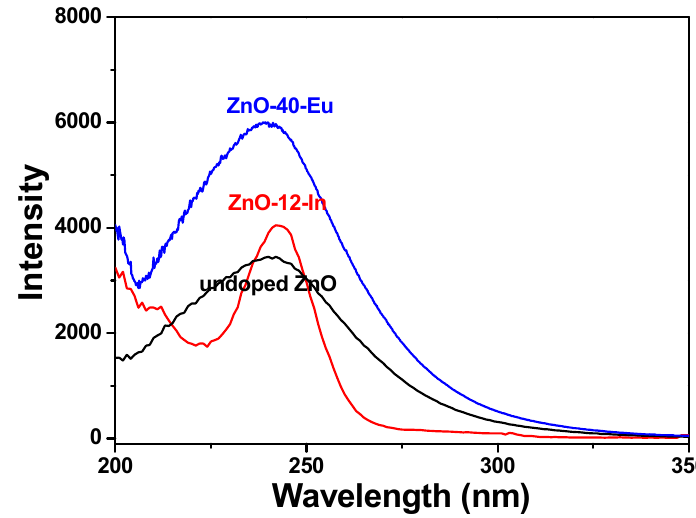
Figure 7. Photoluminescence excitation (PLE) spectra of 100 °C-grown ZnO, 60 °C-grown ZnO-40-Eu, and 88 °C-grown ZnO-4-In nanowires.